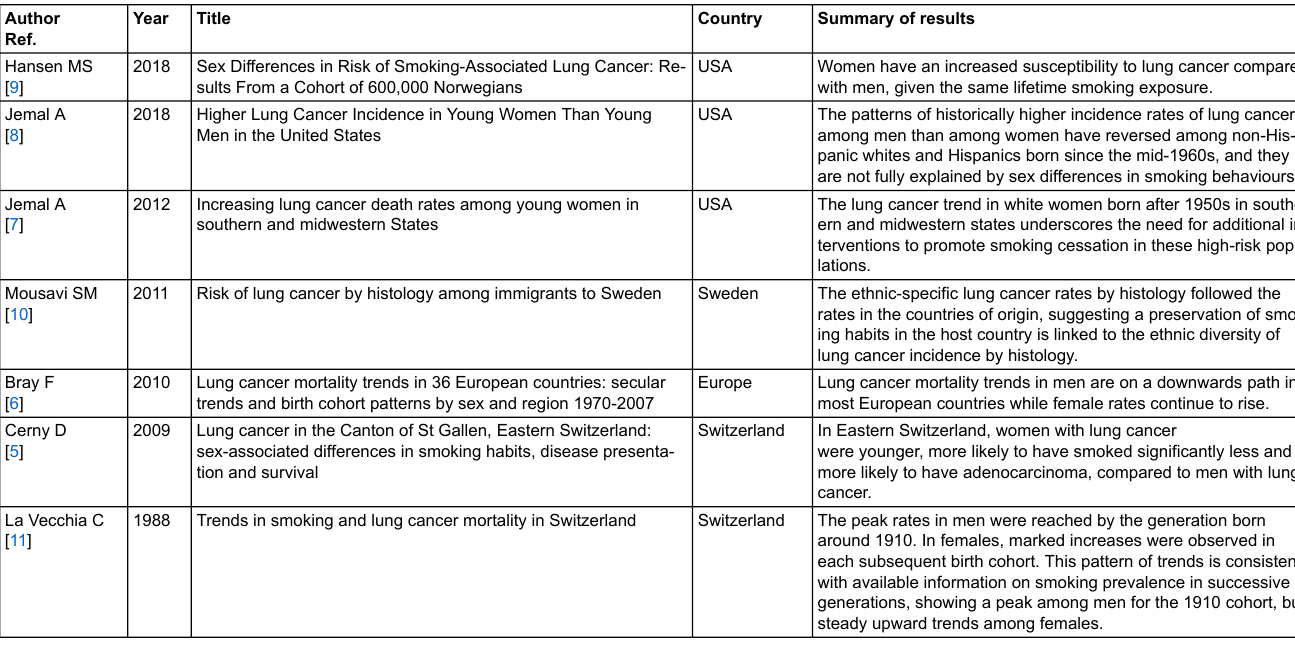
Table 1: Comparing studies on smoking and lung cancer trends by sex. Author